Question: Express in one sentence what the figure is showing.
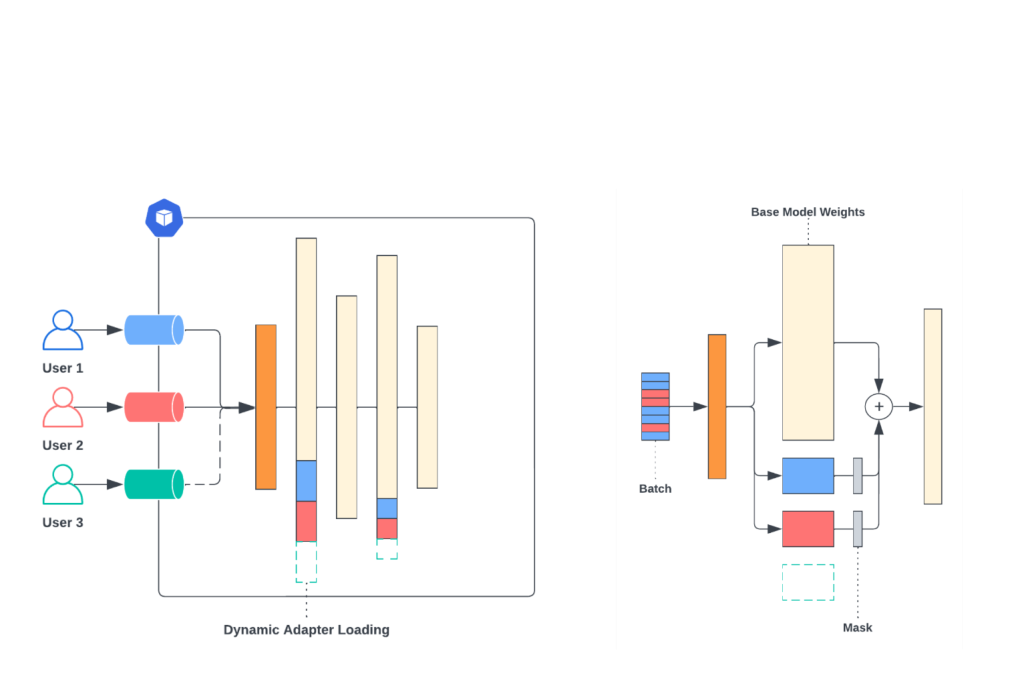
Answer: Dynamic adapter loading (left) enables multiple concurrent fine-tuned models to process requests. User 3’s model (green) is loaded in the background while the other requests proceed as usual. Continuous Multi-Adapter Batching (right): Multiple adapters are decoded in a single batch. Masks ensure that only the right adapter is used for processing each element of the batch.